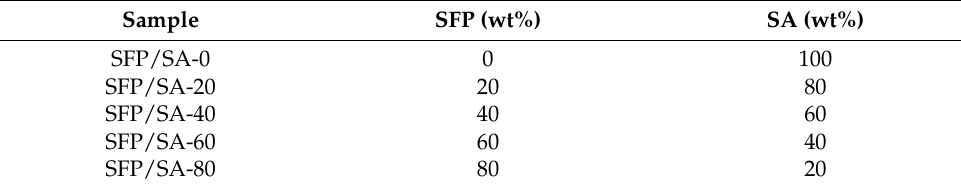
Table 1. Different contents of polysaccharides in